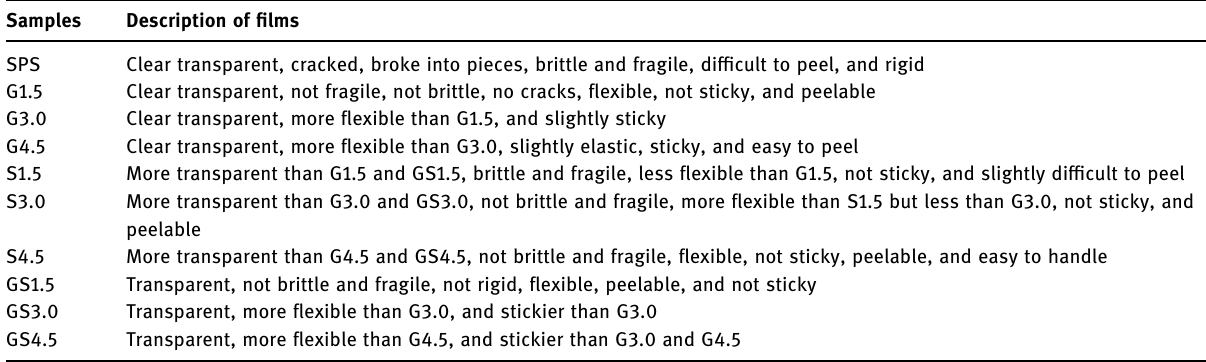
Table 2: Description of bionanocomposite fi lms with and without a plasticizer